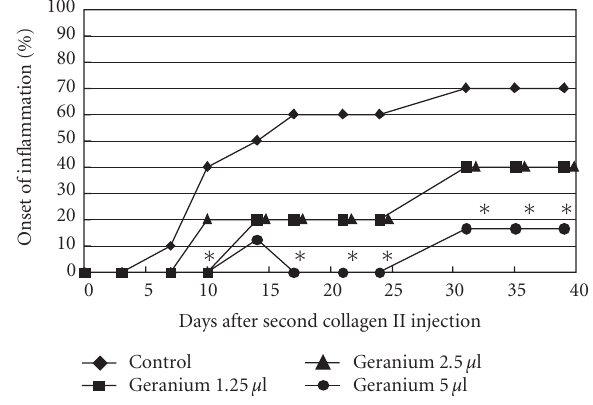
Figure 5: E ff ects of intraperitoneal administration of geranium oil on the ratio of the mice which revealed feet swelling by collagen II induction. Collagen II with CFA was subcutaneously injected to the base of the tail of the mice on days − 21 and 0. Geranium oils were given from day 0 to 21, 5 days/week. Each value represents percent- ages of mice with foot swelling. ∗ P < . 05 di ff erence from control using χ -square test.